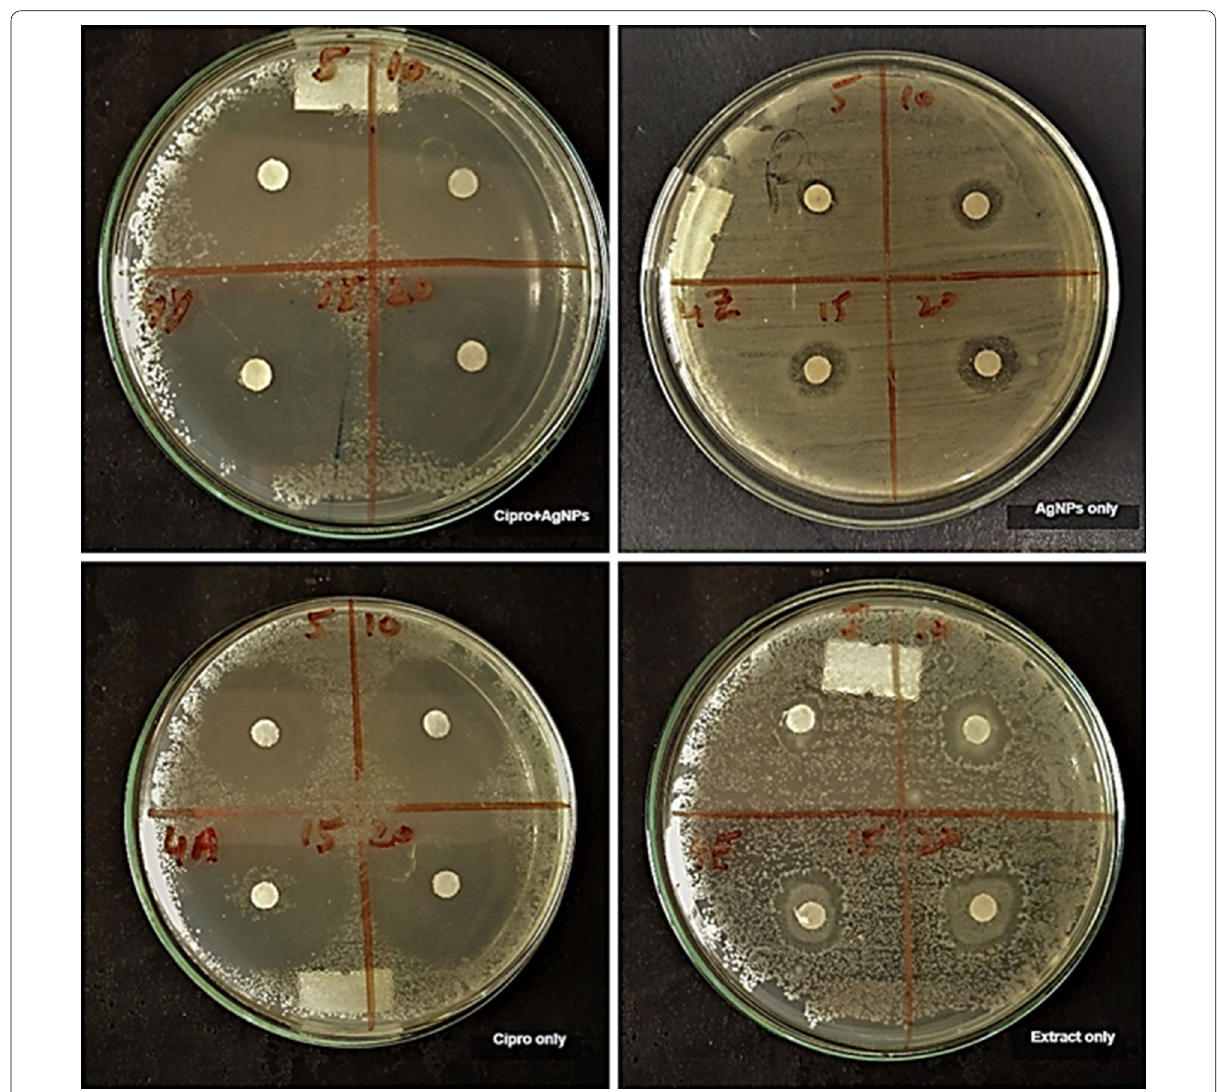
Fig. 4 Activity of ciprofloxacin callus extract mediated AgNPs, callus extract mediated AgNPs, ciprofloxacin only and extract only controls against + Escherichia